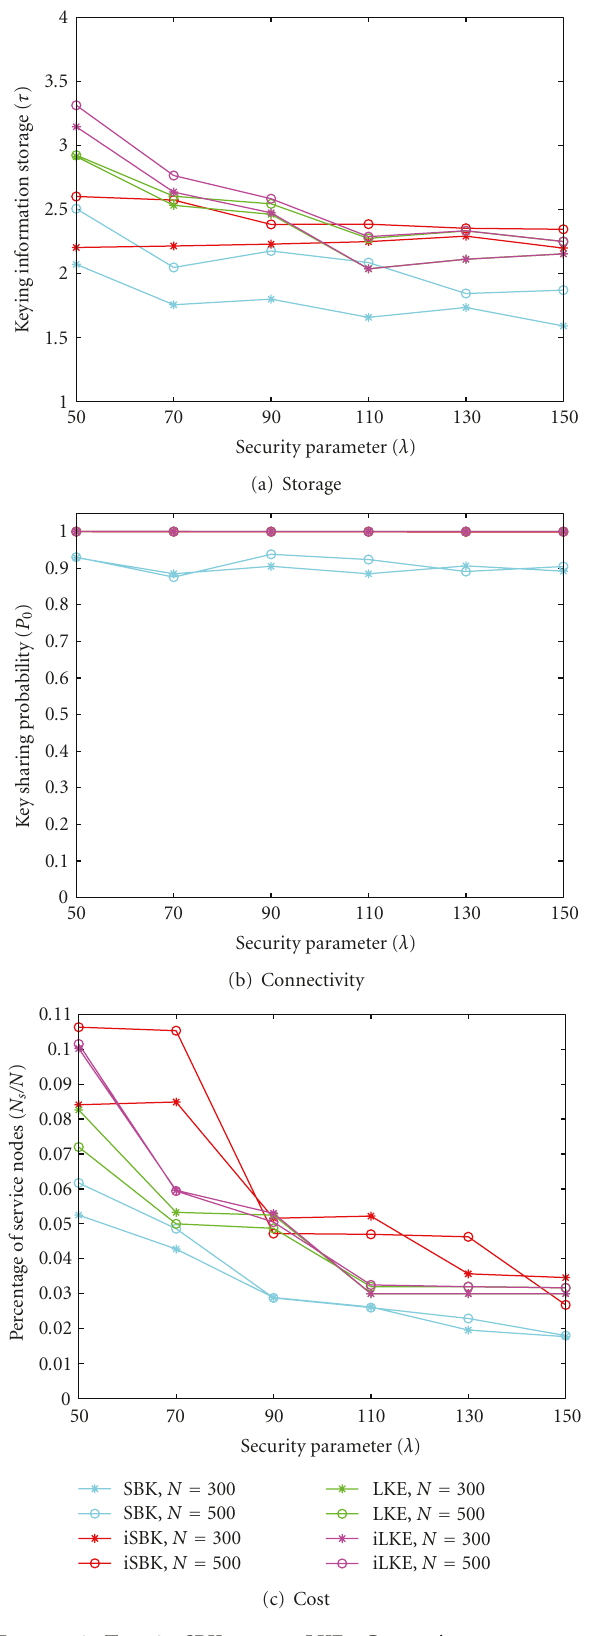
Figure 6: Test 3. SBK versus LKE: Comparison on storage, connectivity, and cost.